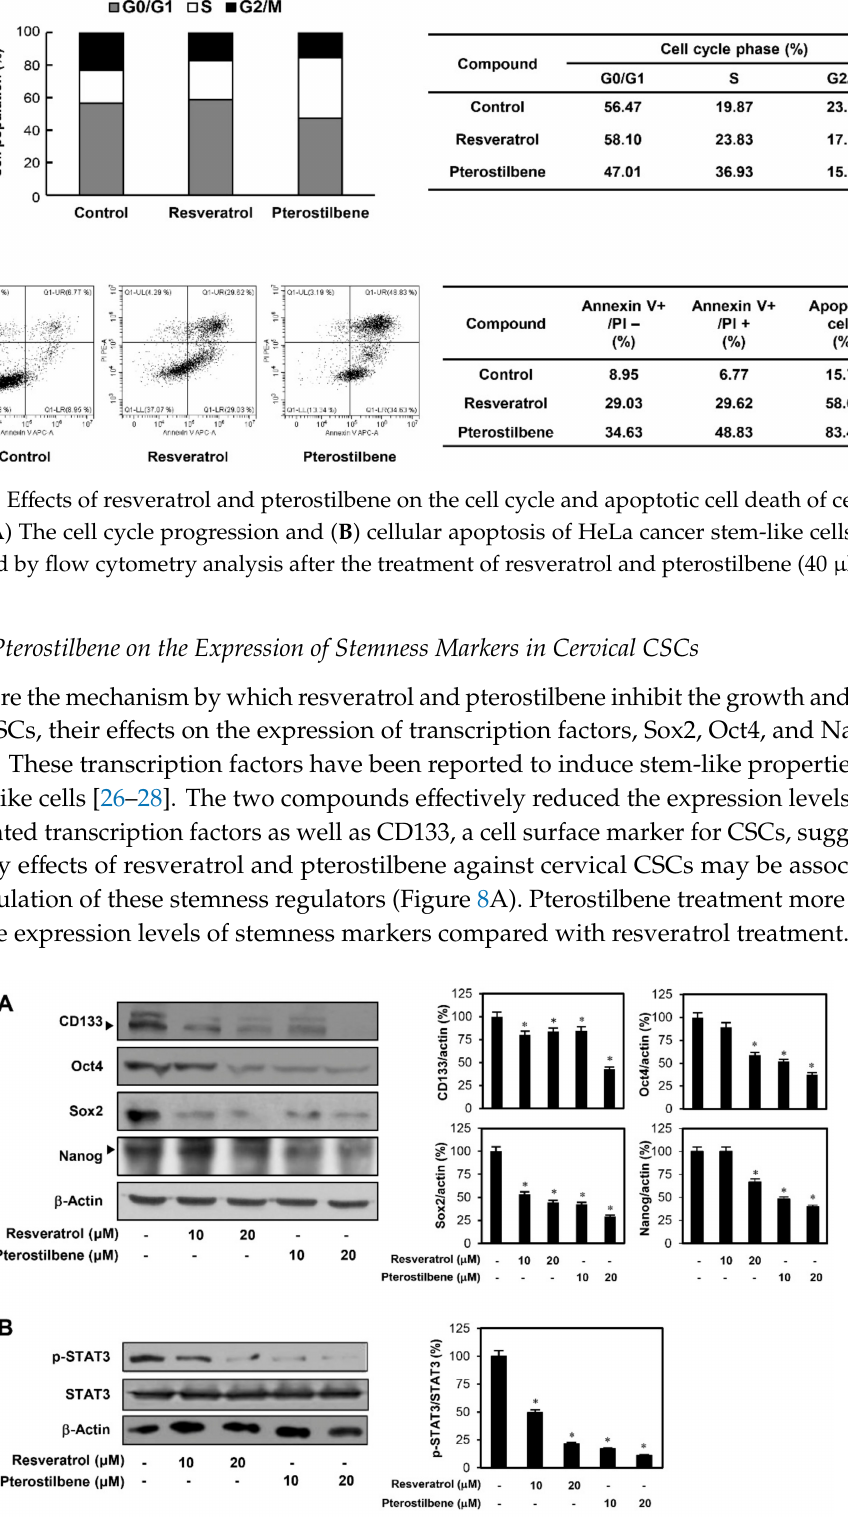
Figure 8. E ff ects of resveratrol and pterostilbene on stemness markers and signal transducer and activator of transcription 3 (STAT3) signaling in cervical CSCs. ( A , B ) HeLa cancer stem-like cells were treated with resveratrol and pterostilbene (10 and 20 µ M) for 48 h, and the protein levels were detected by Western blot analysis using specific antibodies. The levels of β -actin were used as an internal control. Arrowheads indicate true bands for the molecular markers. * p < 0.05 versus the